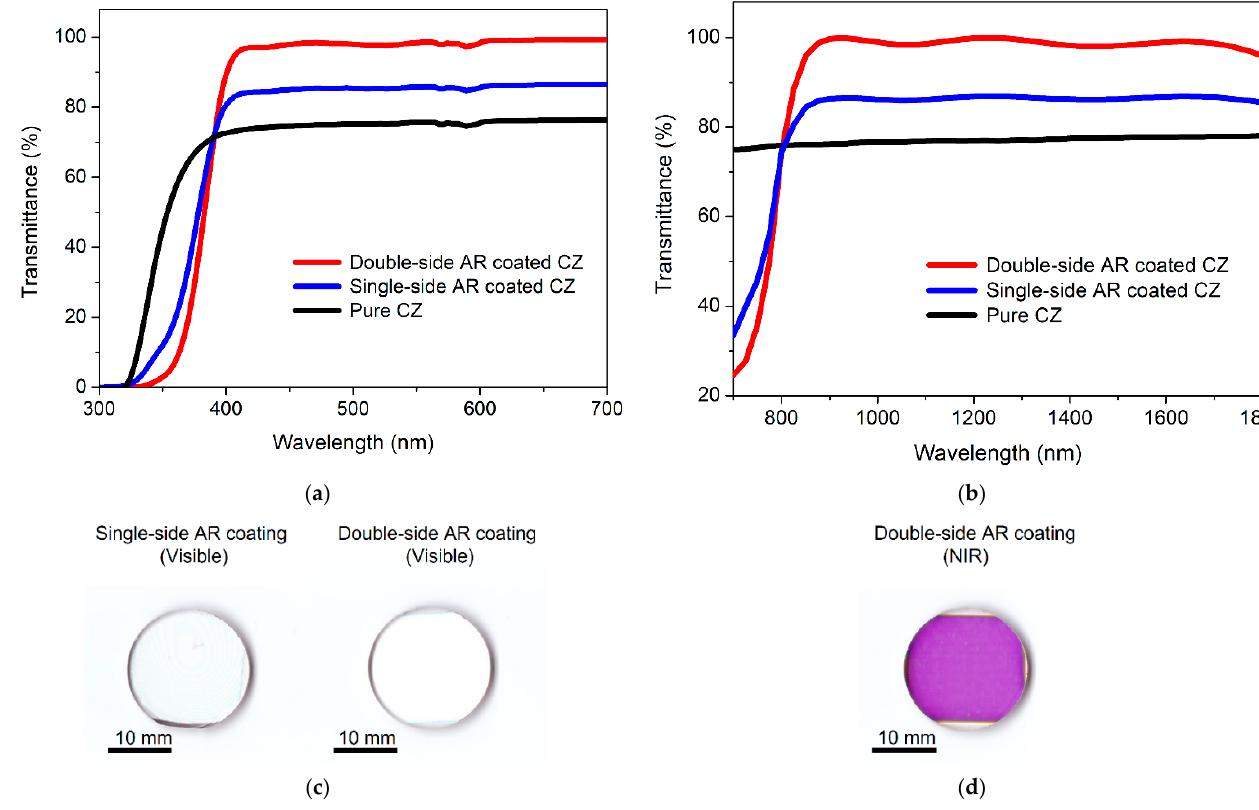
Figure 2. Transmission spectra of the cubic zirconia samples coated with a double-side or single-side AR dielectric multilayer and the pure cubic zirconia sample ( a ) in the visible wavelength and ( b ) NIR wavelength; ( c , d ) pictures of the cubic zirconia samples (19 mm diameter and 5 mm thickness) coated with the visible and NIR broadband AR